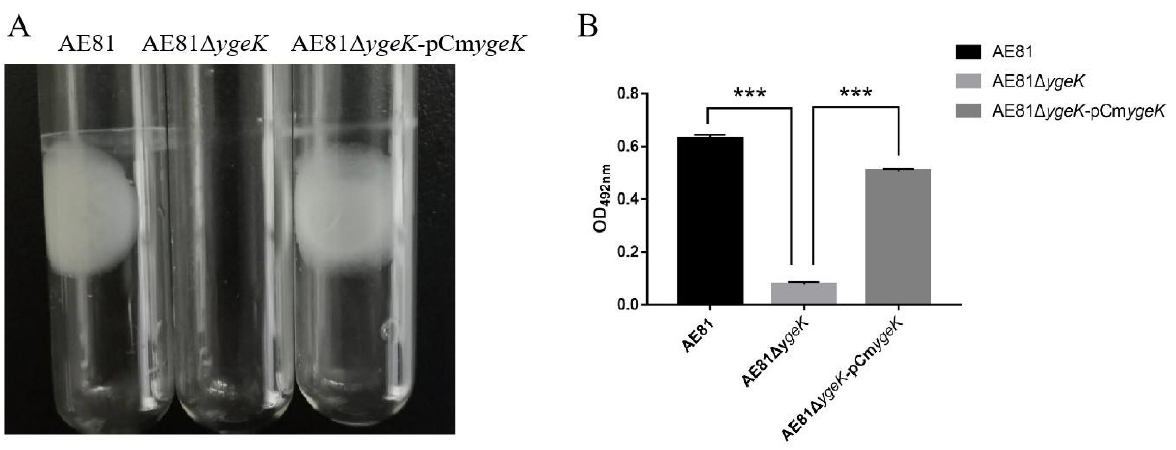
Figure 1. ( A ) Biofilms formed on tubes by AE81, AE81Δ ygeK , and AE81Δ ygeK- p C m ygeK strains . ( B ) Measurement of biofilm mass. Values are average of three independent experiments. Error bars in- dicate standard deviation (*** p < 0.001).